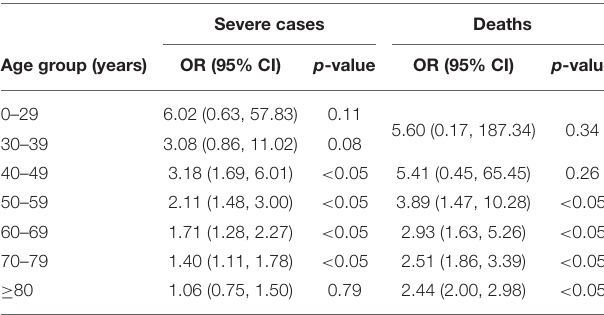
TABLE 2 | Odds ratios of severe cases and deaths due to variant alpha COVID-19 by age